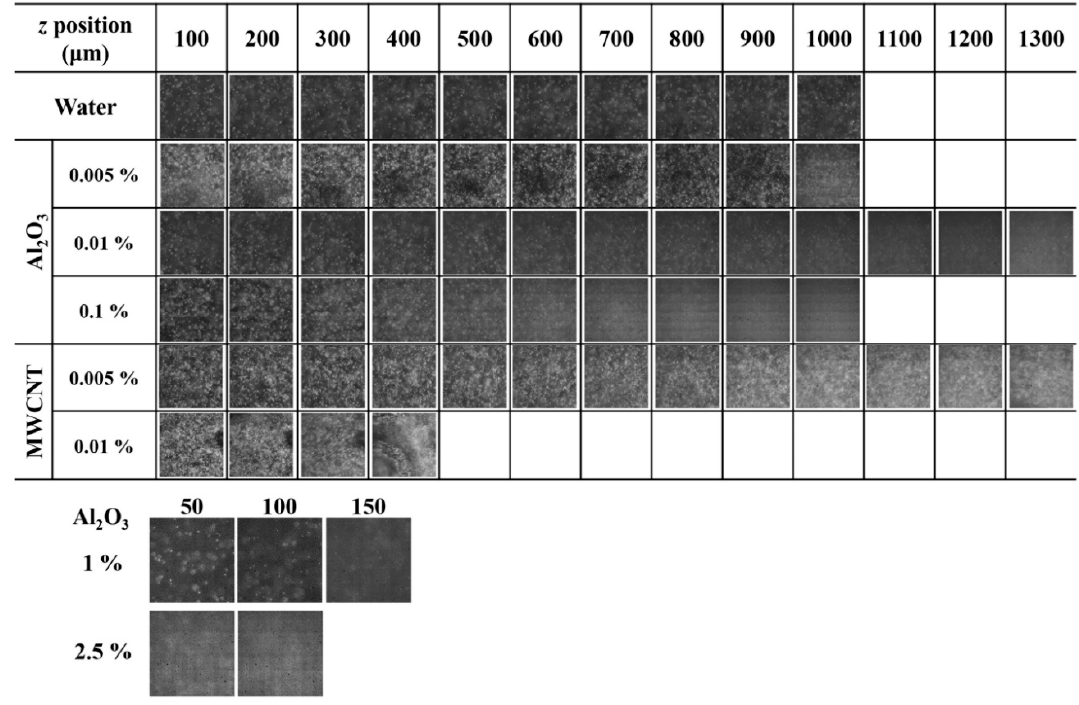
Figure 2. Images of nanofluids with fluorescent microspheres obtained at various z positions.